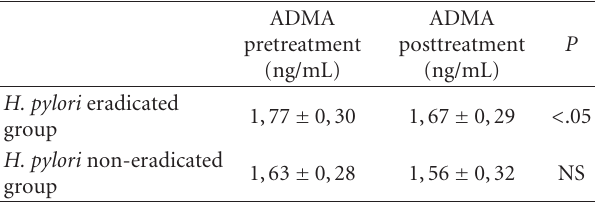
Table 1: Pretreatment and posttreatment ADMA